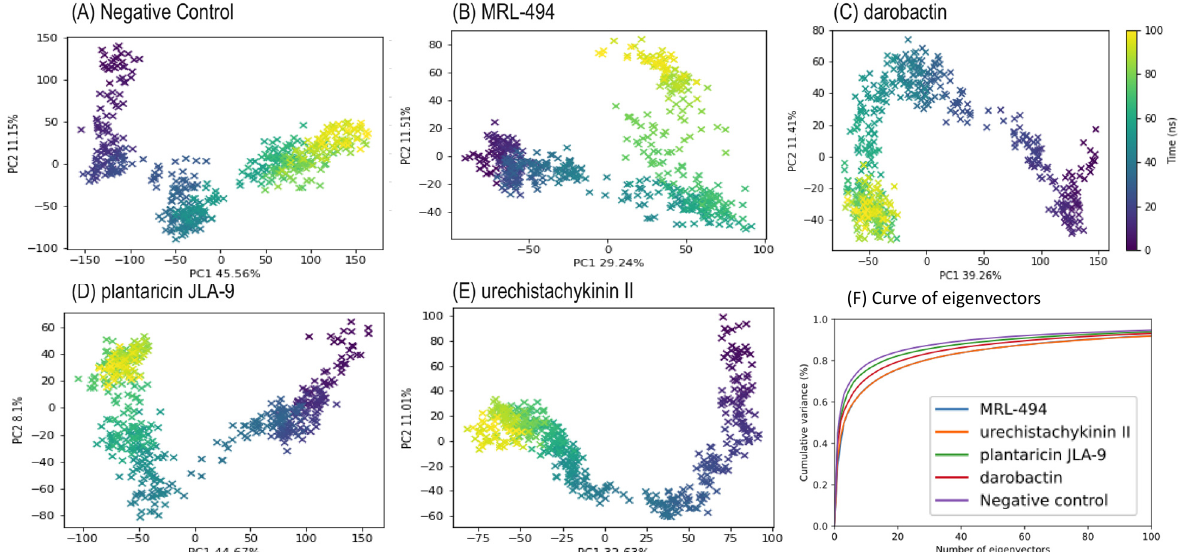
Figure 6. PCA on C α atoms from the MD simulation constructed by the first two eigenvectors, PC1, and PC2. ( A ) Apo-protein (Negative control). ( B ) MRL-494. ( C ) Darobactin. ( D ) Plantaricin JLA-9 ( E ) Urechistachykinin II. ( F ) explained variance curves of the first 100 principal components for these five simulations.